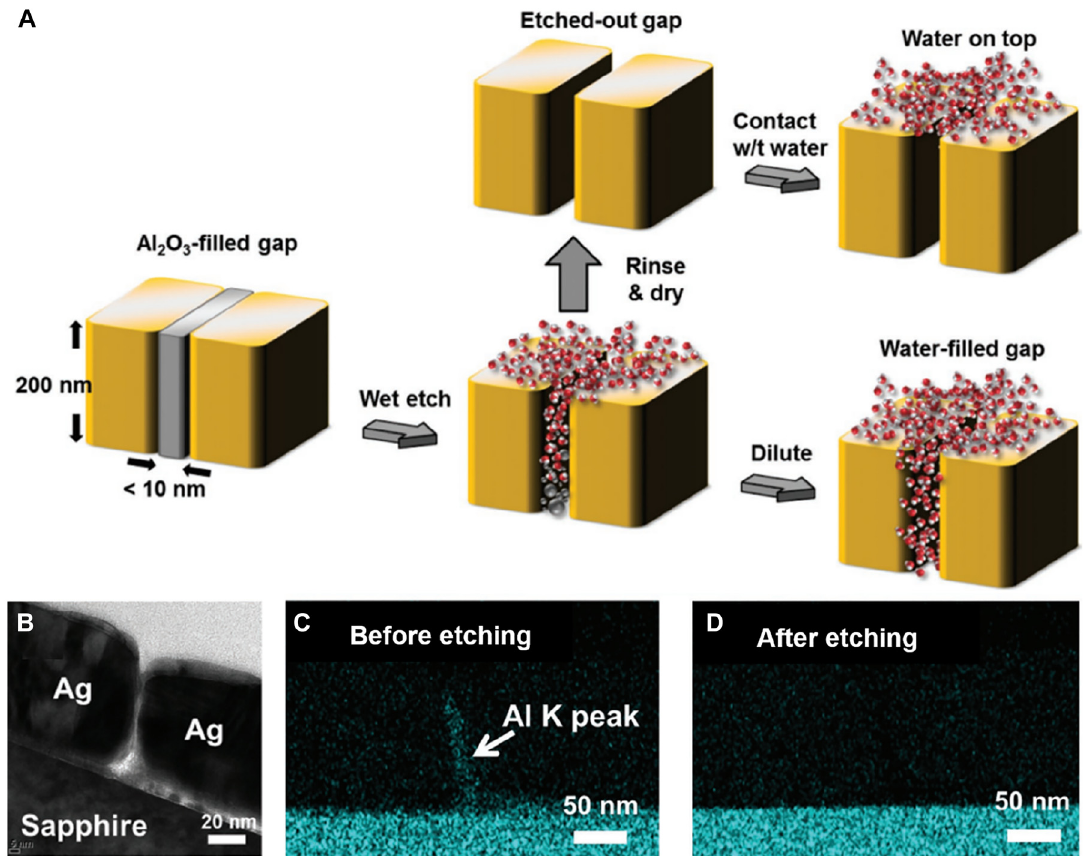
Figure 12: (A) Wet-etching the gap-filling dielectric in metal – insulator – metal (MIM) gap. While water and etchant molecules cannot enter an empty metallic gap due to surface tension, they can enter a gap filled with dielectric as the reaction between the etchant and the dielectric is thermodynamically favored. (B) Cross-sectional transmission electron microscope (TEM) image of a few-nanometer gap retaining its shape after the wet etching process. (C) and (D) Energy-dispersive X-ray spectroscopy mapping of an MIM gap before and after etching, showing successful removal of gap- fi lling aluminum oxide. Reproduced with permission from